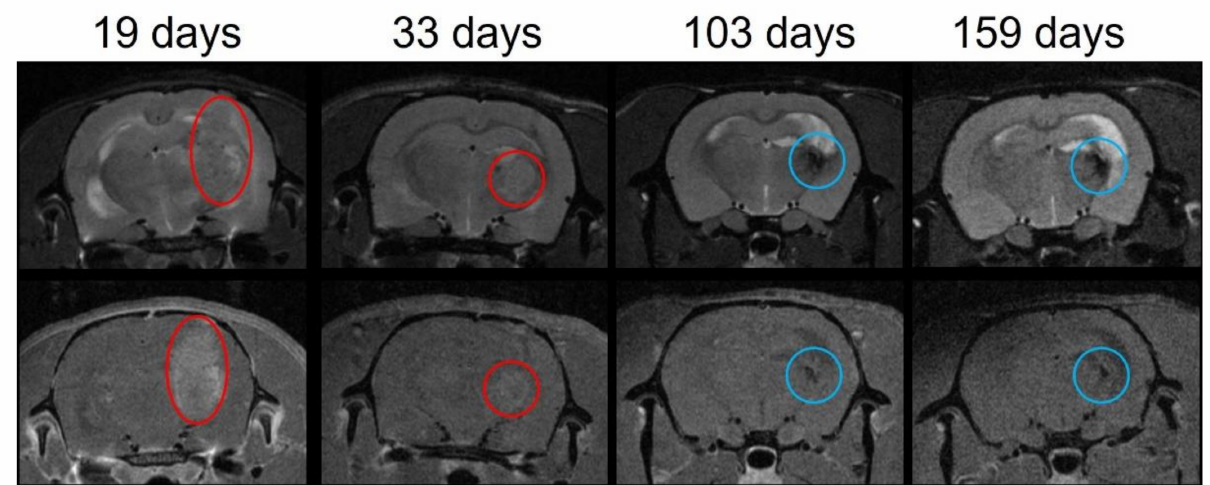
Figure 4. Example of the longitudinal MRI follow-up of one of the long-term survivors of group 4. Upper row: T2 images. Lower row: T1 RARE images after Gadolinium (Gd) injection. The tumor is identified by the red circle. A large tumor is observed at day 19 after irradiation (V = 104.82 mm 3 on the T1 after Gd injection). The tumor size has diminished at day 33 after irradiation (V = 21.55 mm 3 on the T1 after Gd injection). No tumor was observed at 103 nor 159 days after irradiation. The blue circle identified the lesion at the tumor bed